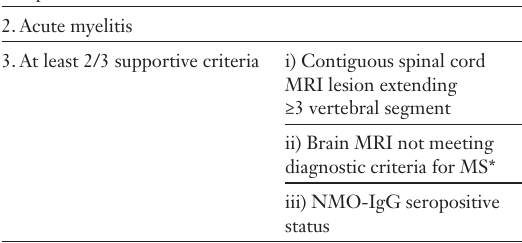
New diagnostic criteria (2005) for definite NMO